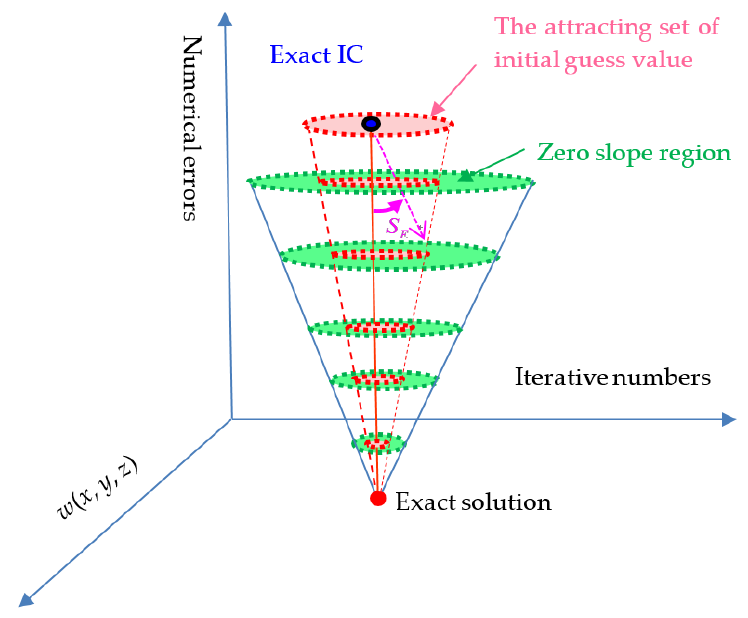
Figure 1. A sketch of the convergence path of the constraint FTIM.